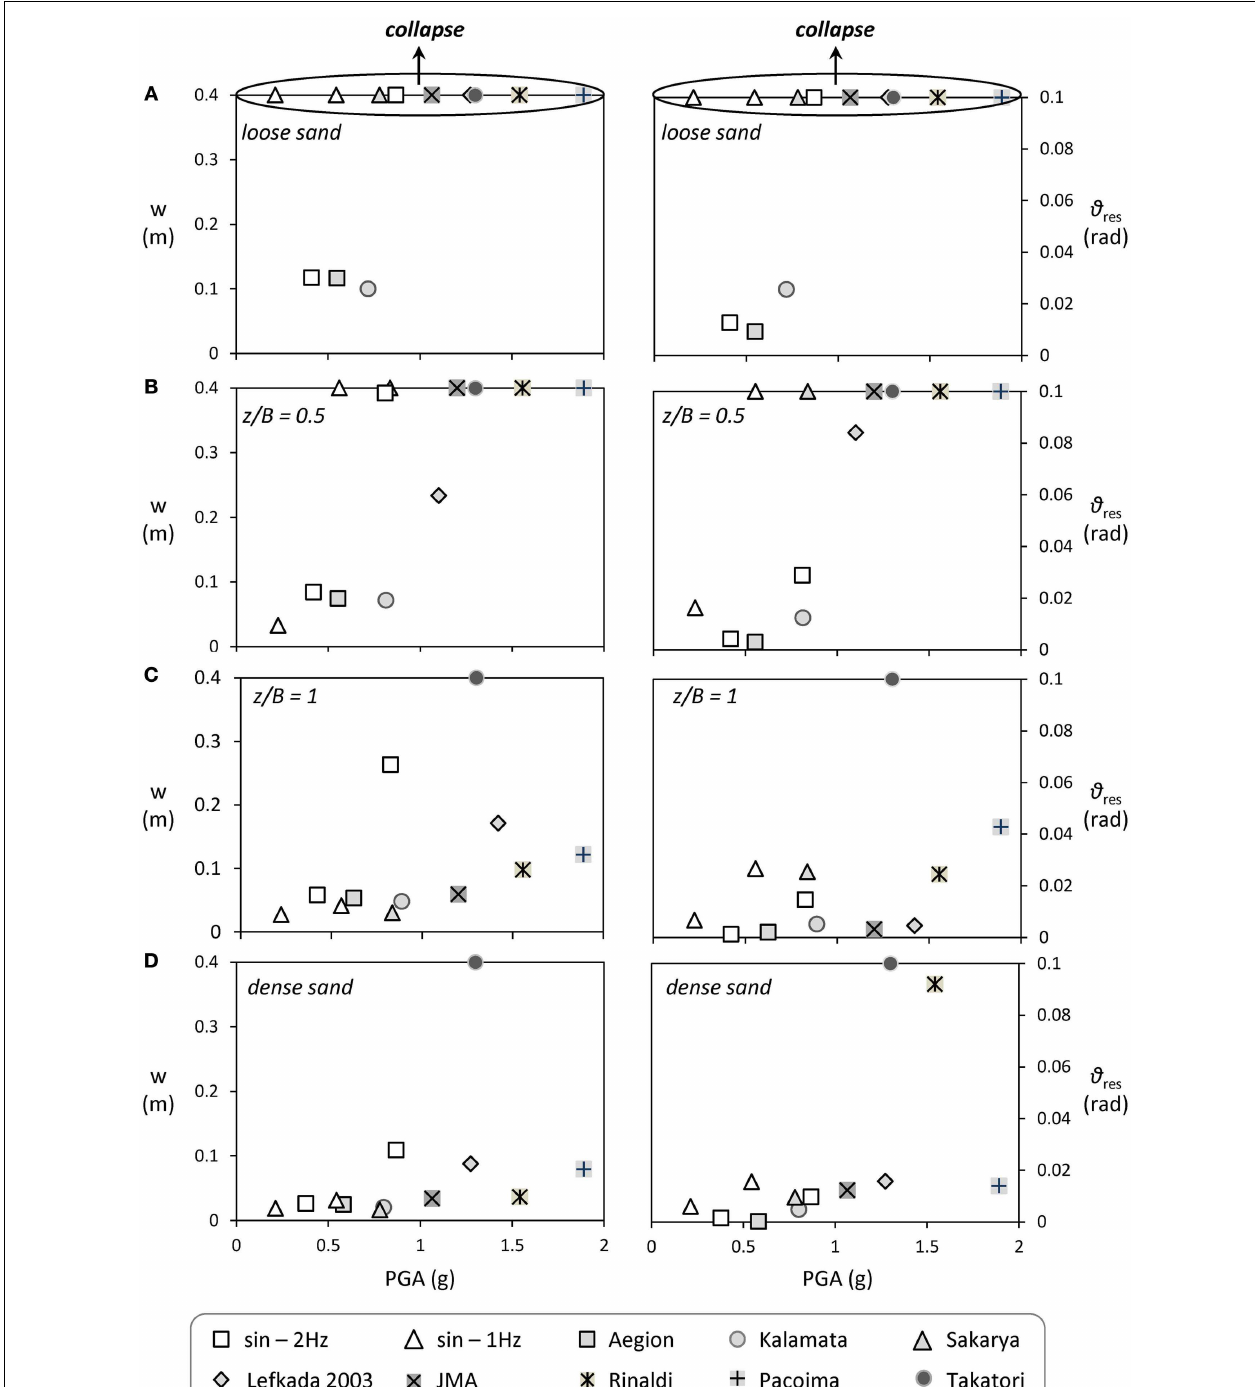
FIGURE 11 | Synopsis of the performance of the lightly loaded System A subjected to seismic shaking sequences I and II . Settlement w (left) and residual rotation ϑ res (right) as a function of PGA: (A) loose sand-poor soil conditions; (B) z/B = 0.5; (C) z/B = 1; and (D) dense sand-ideal soil conditions.